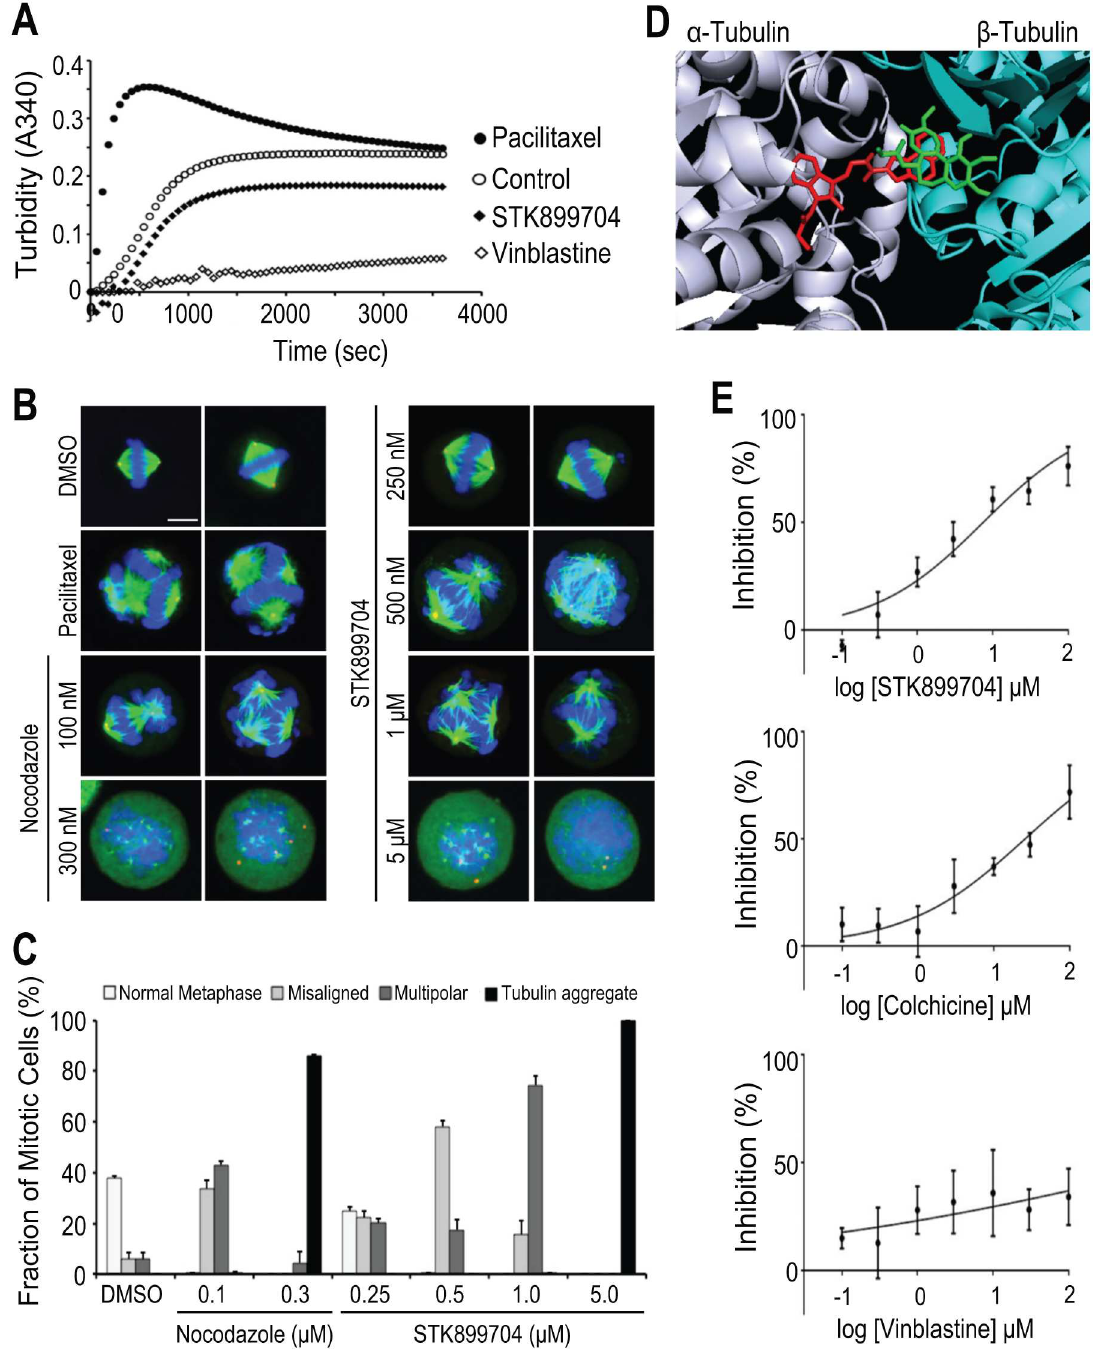
Fig 3. STK899704 inhibited tubulin polymerization and mitotic spindle organization. (A) Tubulinpolymerization assay. The effect of STK899704 (5 μ M) on polymerization of purifiedtubulin in vitro was examinedin a GTP-containingbuffer. DMSO was used as a negative control. Tubulin-targeting agents Taxol (5 μ M) and vinblastine(5 μ M) were also used as controls for tubulin-stabilizing and tubulin-destabilizingagents, respectively. Assemblyof tubulin into microtubules was determined by the degreeof turbidity at 340 nm. (B) Immunofluorescence stainingof microtubules in HeLa cells. Cells were treated with DMSO, Taxol (100 nM), nocodazole (200 ng/ml), or indicatedconcentrations of STK899704 for 17 h. Cells were then fixed and stained with Alexa Fluor 488-conjugated anti-tubulinantibody and Hoechst 33342 to visualize α -tubulin and DNA, respectively.Scale bar, 10 μ m. (C) Fraction of mitotic cells. At least 100 cells from (B) were countedfrom the different regions. Percentages of normal metaphase,misaligned,multipolar,and tubulin aggregate phenotypeswere shown. (D) Proposedbindingmodel of